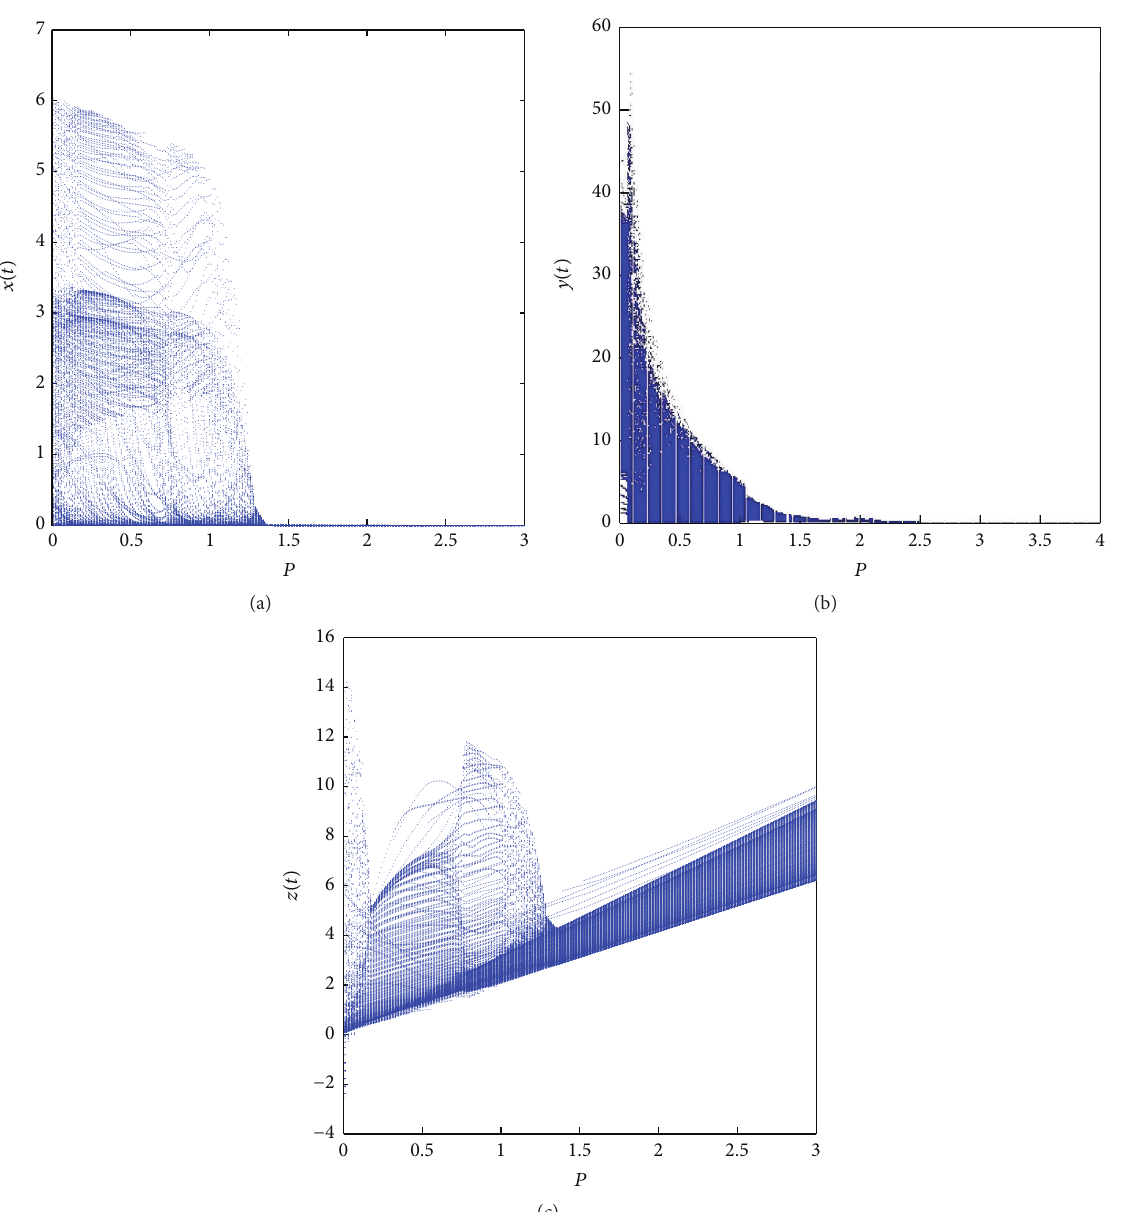
Figure 13: Bifurcation diagram of system (2) with mixed Holling type II functional responses ( 𝑝 = 1 , 𝑞 = 1 , 𝑠 = 1 , and 𝑟 = 1 ) (a) with respect to 𝑥(𝑡) , (b) with respect to 𝑦(𝑡) , and (c) with respect to 𝑧(𝑡) , in presence of seasonal perturbation where 𝑃 varies from 0.01 to 3 with data set (45) and 𝑇 = 1